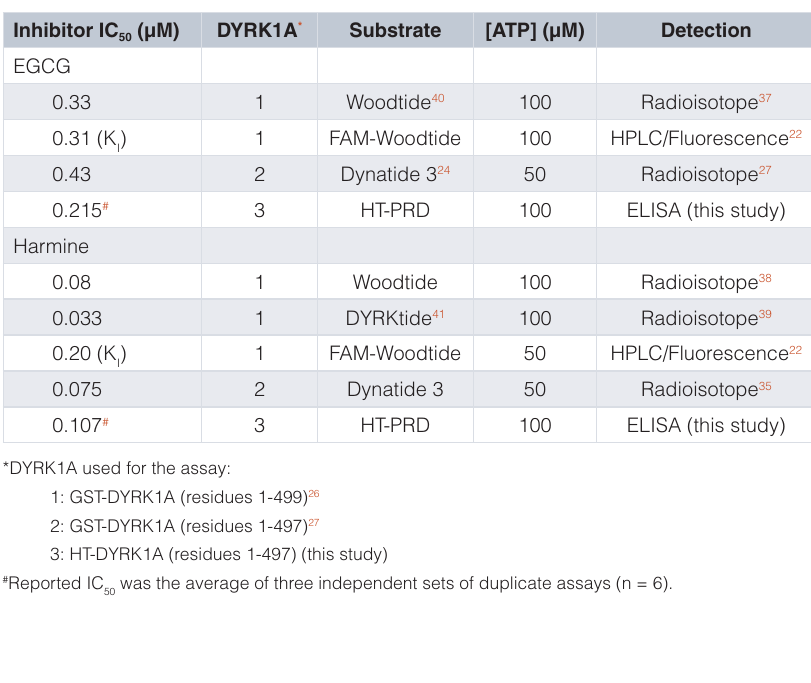
Table 1. List of IC for epigallocatechin gallate (EGCG) and harmine obtained by 50 different approaches.